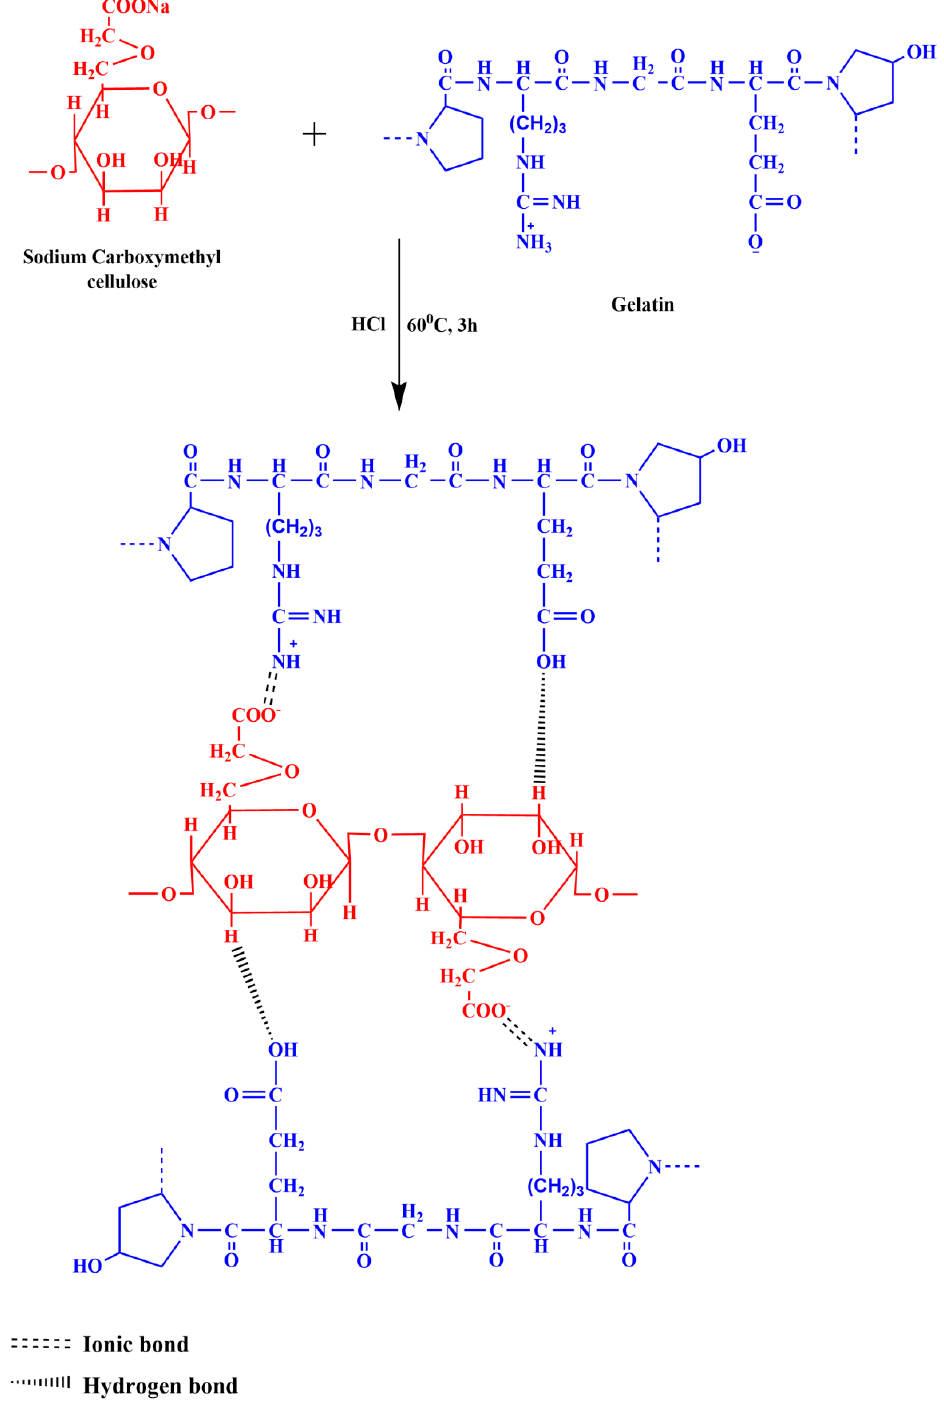
Figure 3. Interaction between NaCMC and